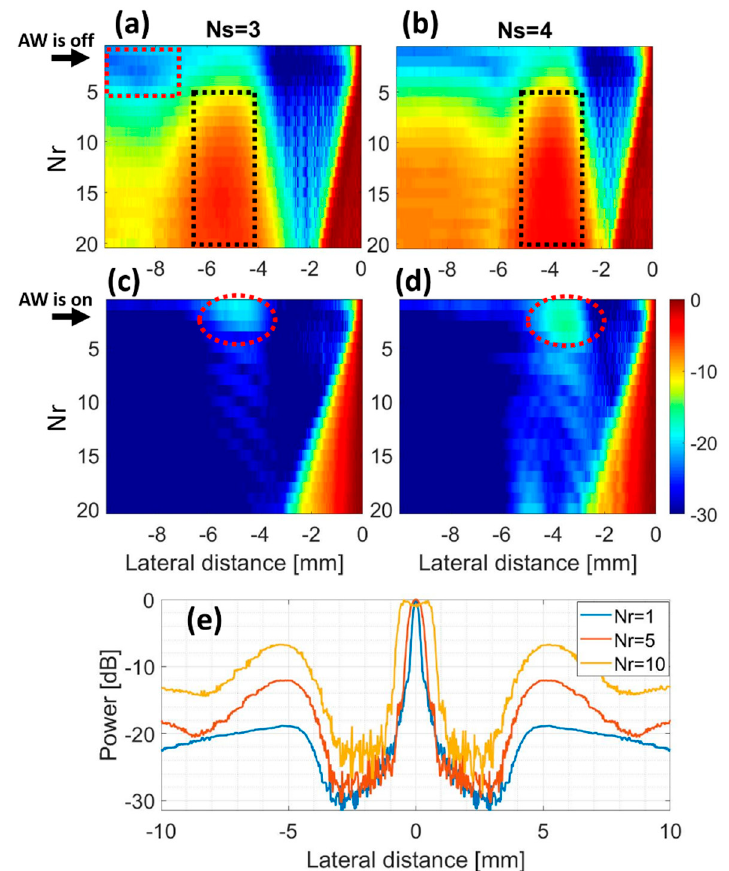
Figure 4. ( a – d ) The point spread functions (PSFs) obtained for different Nr and Ns when a full-aperture transmission is used. A point scatterer was positioned at the depth of 10 mm and the lateral distance of 0 mm. The angular weighting (AW) technique was used in the bottom row. The black and red rectangular regions were used to calculate the clutter level (Figure 5a) and effects of grating lobes (Figure 5b). The red circles show the effects of grating lobes. ( e ) The lateral variation for Ns = 3 when the AW is on.